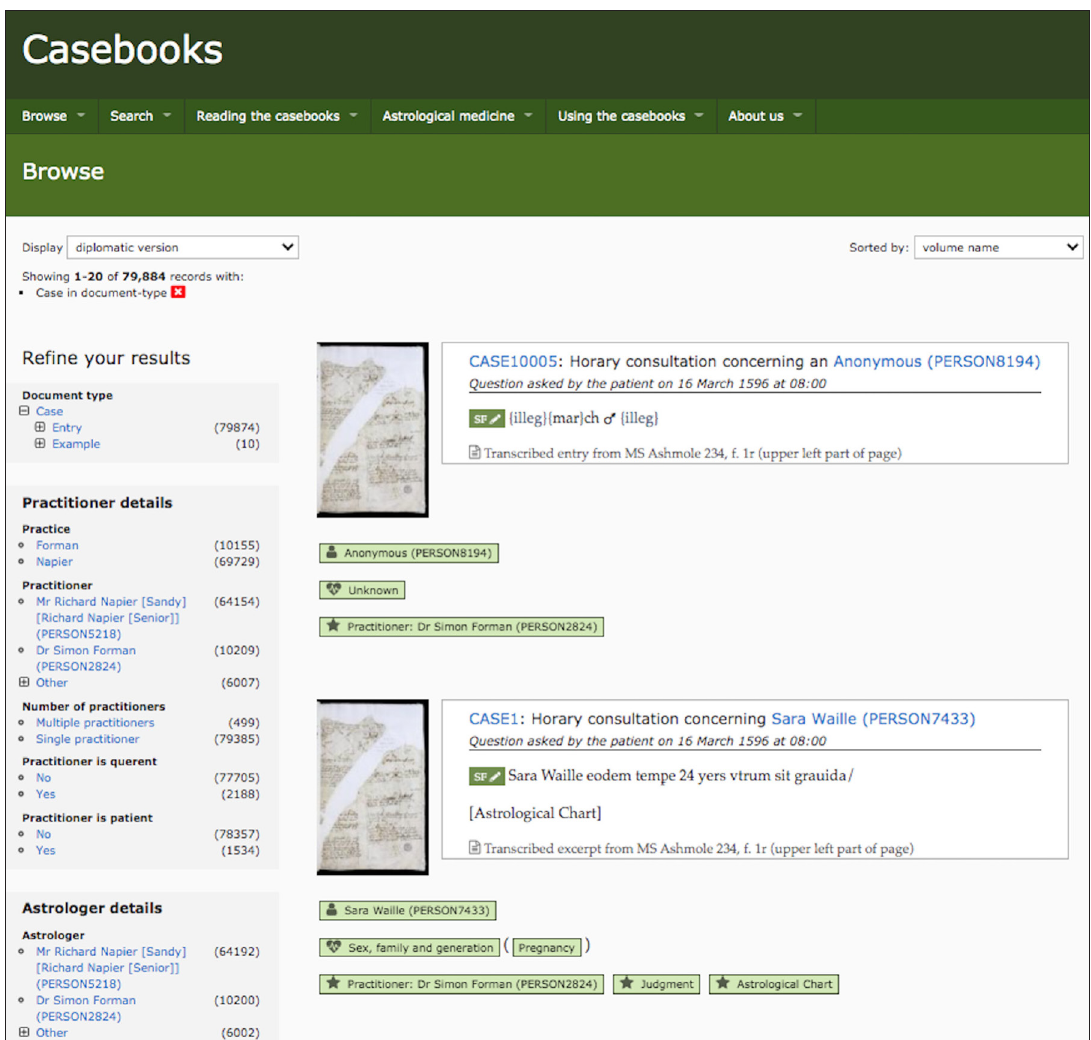
Figure 2: A screenshot of the browse and search interface of Lauren Kassell, Michael Hawkins, Robert Ralley, John Young, Joanne Edge, Janet Yvonne Martin-Portugues, and Natalie Kaoukji, eds., Casebooks Digital Edition , https://casebooks.lib.cam.ac.uk/search?sort=sort-volume-name;f1-document-type=Case. The wide column on the right shows the edited cases with a thumbnail of the manuscript. The narrow column on the left shows the facets that can be refined according to document type, practitioner details, patient details, how, where, and when a consultation took place, information about its contents from the question to payment, and editorial information. The facets also represent the “top ten” patients and querents matching selected categories. Drop down menus at the top allow for a choice of displays (diplomatic, normalized, or normalized with translation) and of criteria for sorting (by date, volume, or